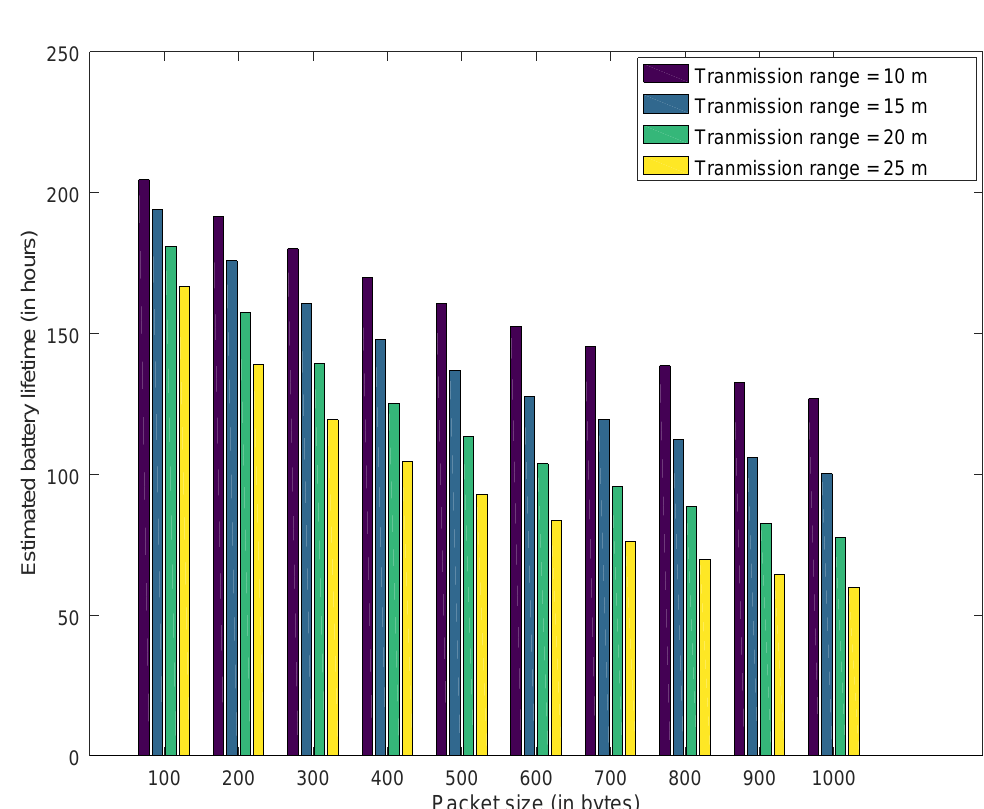
Figure 16. Estimated Battery Lifetime—Worst